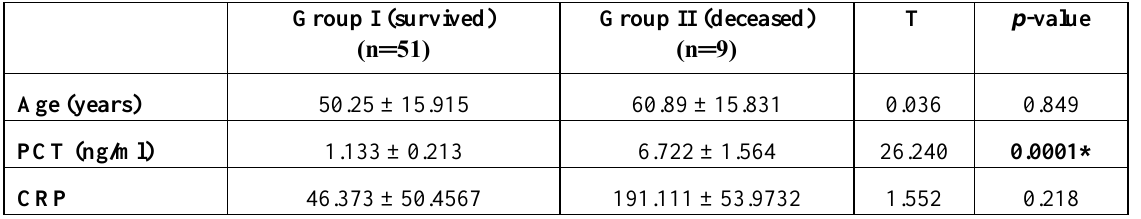
Table 1. Age, procalcitonin, C-reactive protein values in relation to survival